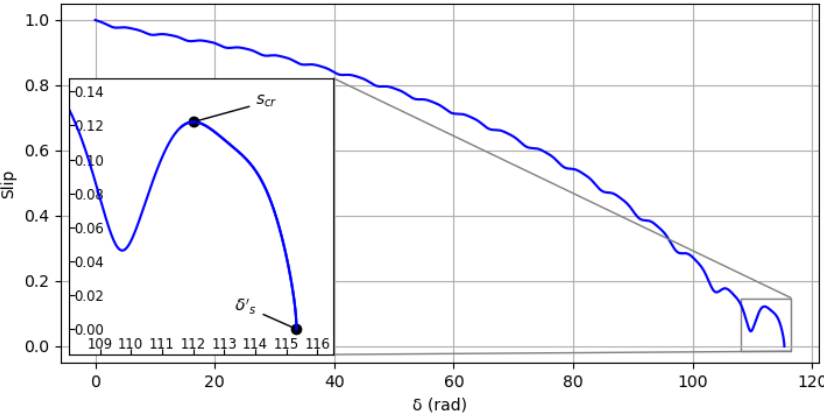
Figure 6. Slip as a function of δ